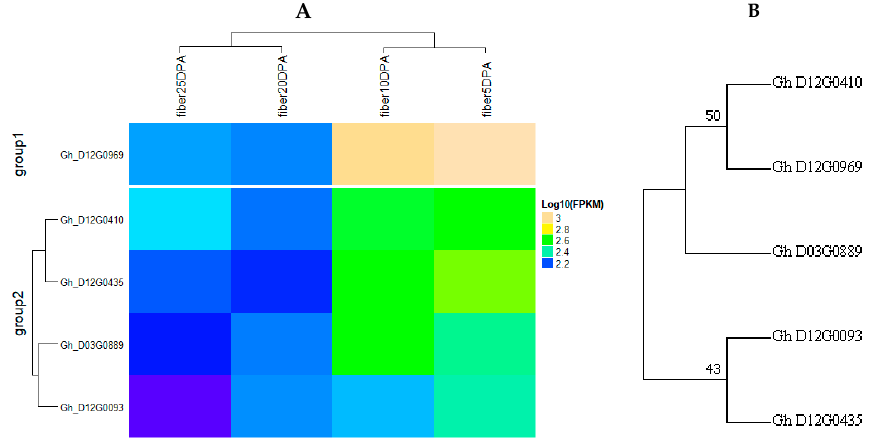
Figure 7. ( A ) Candidate genes involved in yield and/or fiber quality traits in this study; ( B ) phylogenetic tree analysis of the five involved genes in yield related and fiber quality traits of upland cotton.